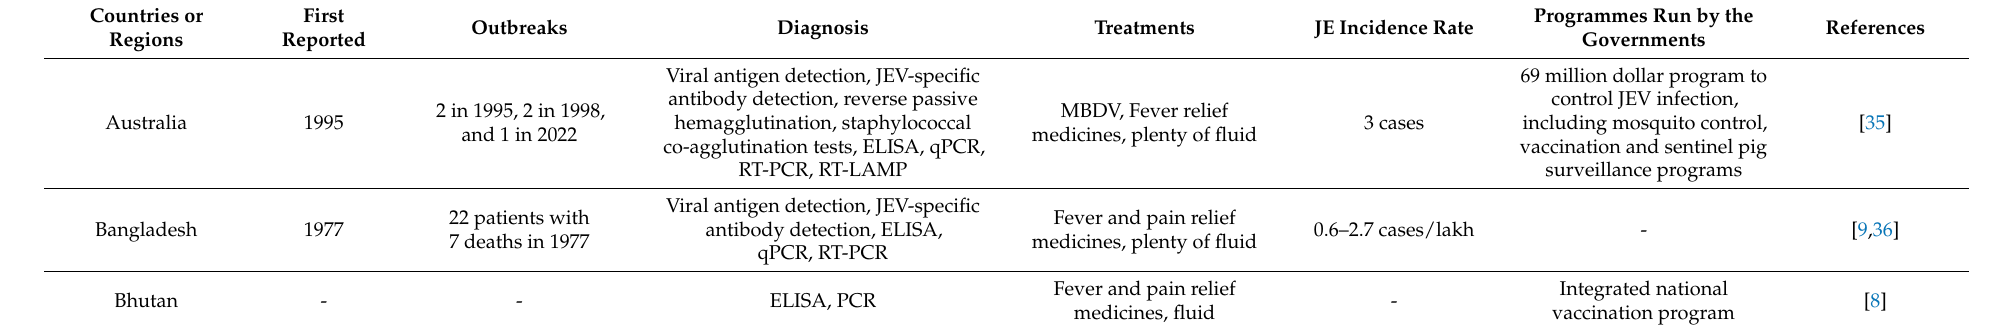
Table 2. The country or region-wise outbreak, diagnosis, treatment, incidence, and programs run by the government: A global scenario of